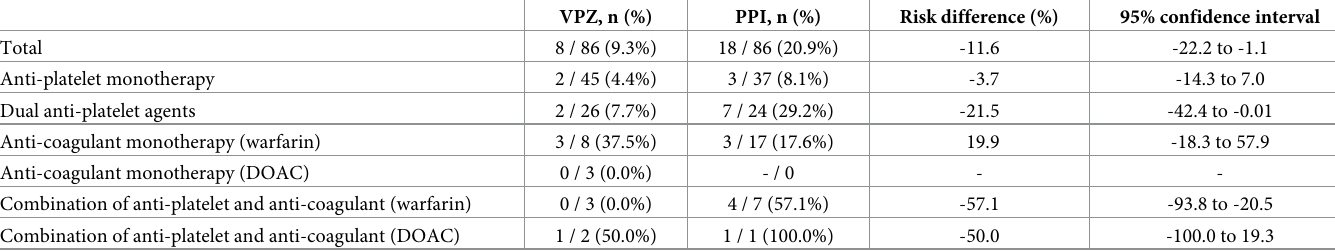
Table 5. Post-ESD bleeding by types of antithrombotic drugs